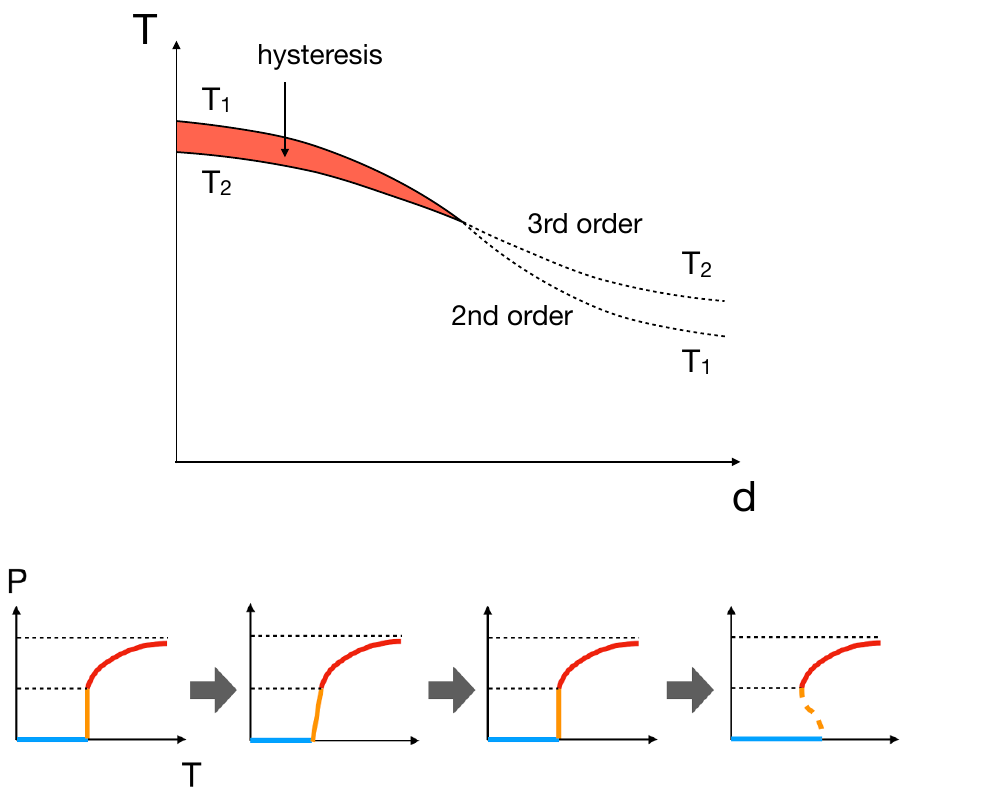
Figure 21. An educated guess about the d -dependence of the phase diagram, from d = 1 to small d . [Top] The dependence of the critical temperatures T 1 and T 2 on d . [Bottom] The P -vs- T plot for various d , from large (left) to small (right). Blue, orange and red lines are con(cid:12)ned, partially decon(cid:12)ned and completely decon(cid:12)ned phases, respectively. At d = 1 , T 1 = T 2 , and at large but (cid:12)nite d , T 1 < T 2 [4]. We have observed a (cid:12)rst order transition, and hence T 1 > T 2 for D (cid:20)